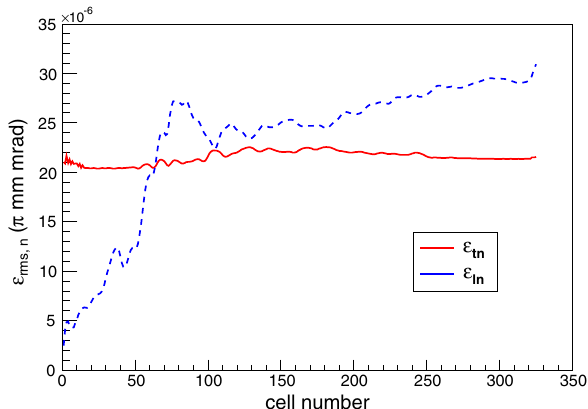
FIG. 4. Trajectories of the phase-advance ratio and depression of RFQ III on the Hofmann chart. The longitudinal/transverse emittances ratio of this Hofmann chart is